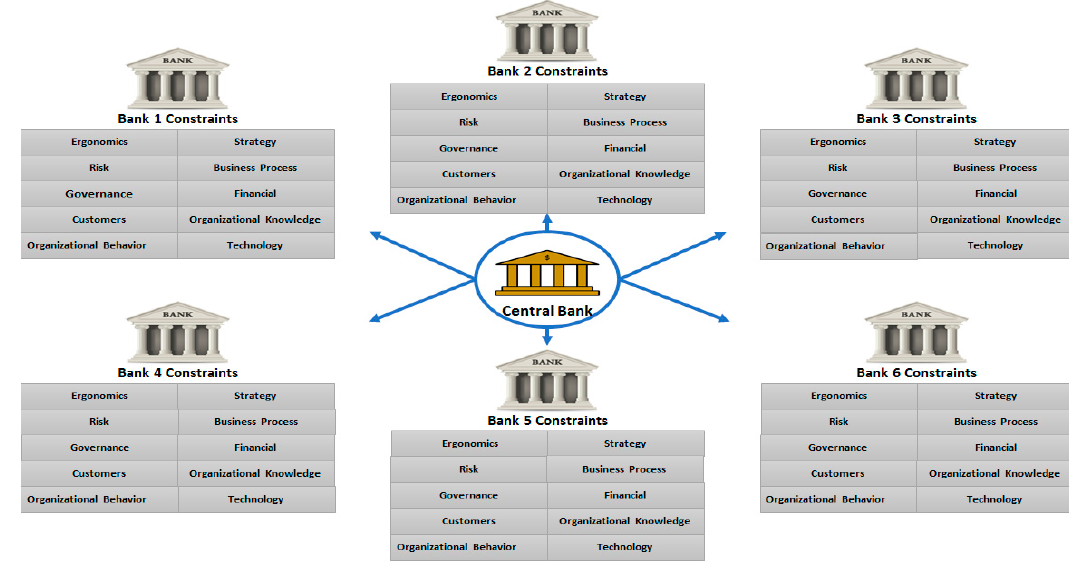
Figure A2. Central bank regulatory policy quality-attribute constraints with commercial banks.